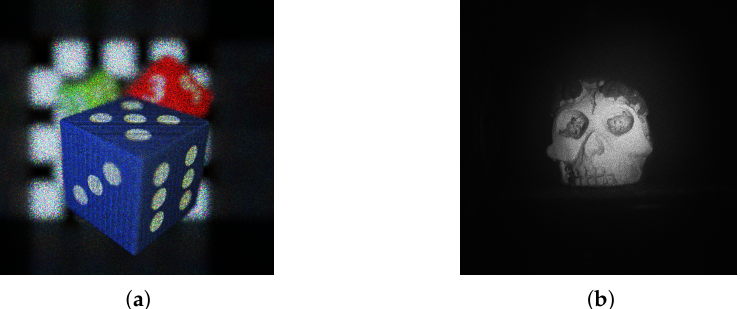
Figure 3. Numerical reconstructions examples: ( a ) B-com Dices 8K reconstructed with ASM, and ( b ) EmergImg Skull reconstructed with the Fresnel